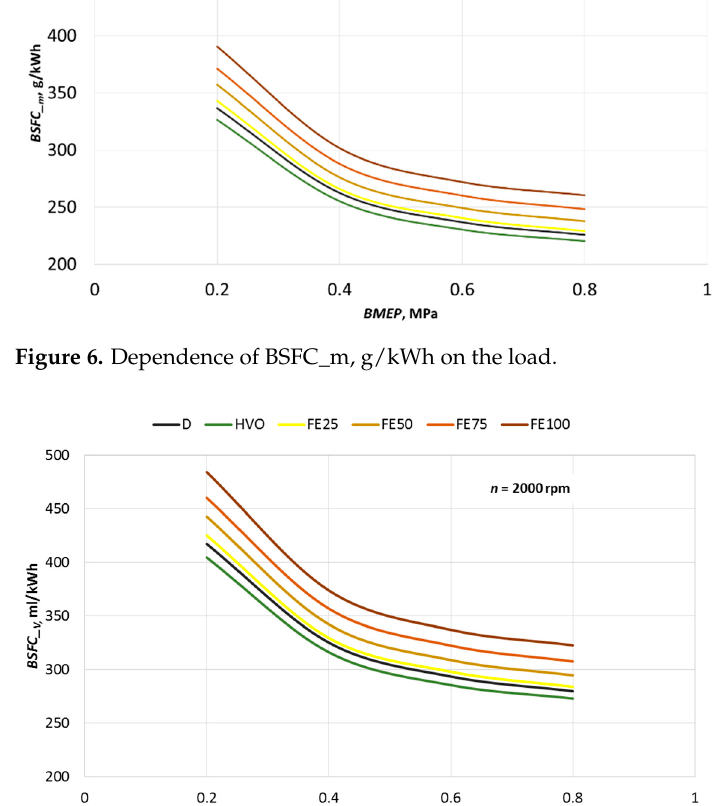
Figure 6. Dependence of BSFC_m, g/kWh on the load.